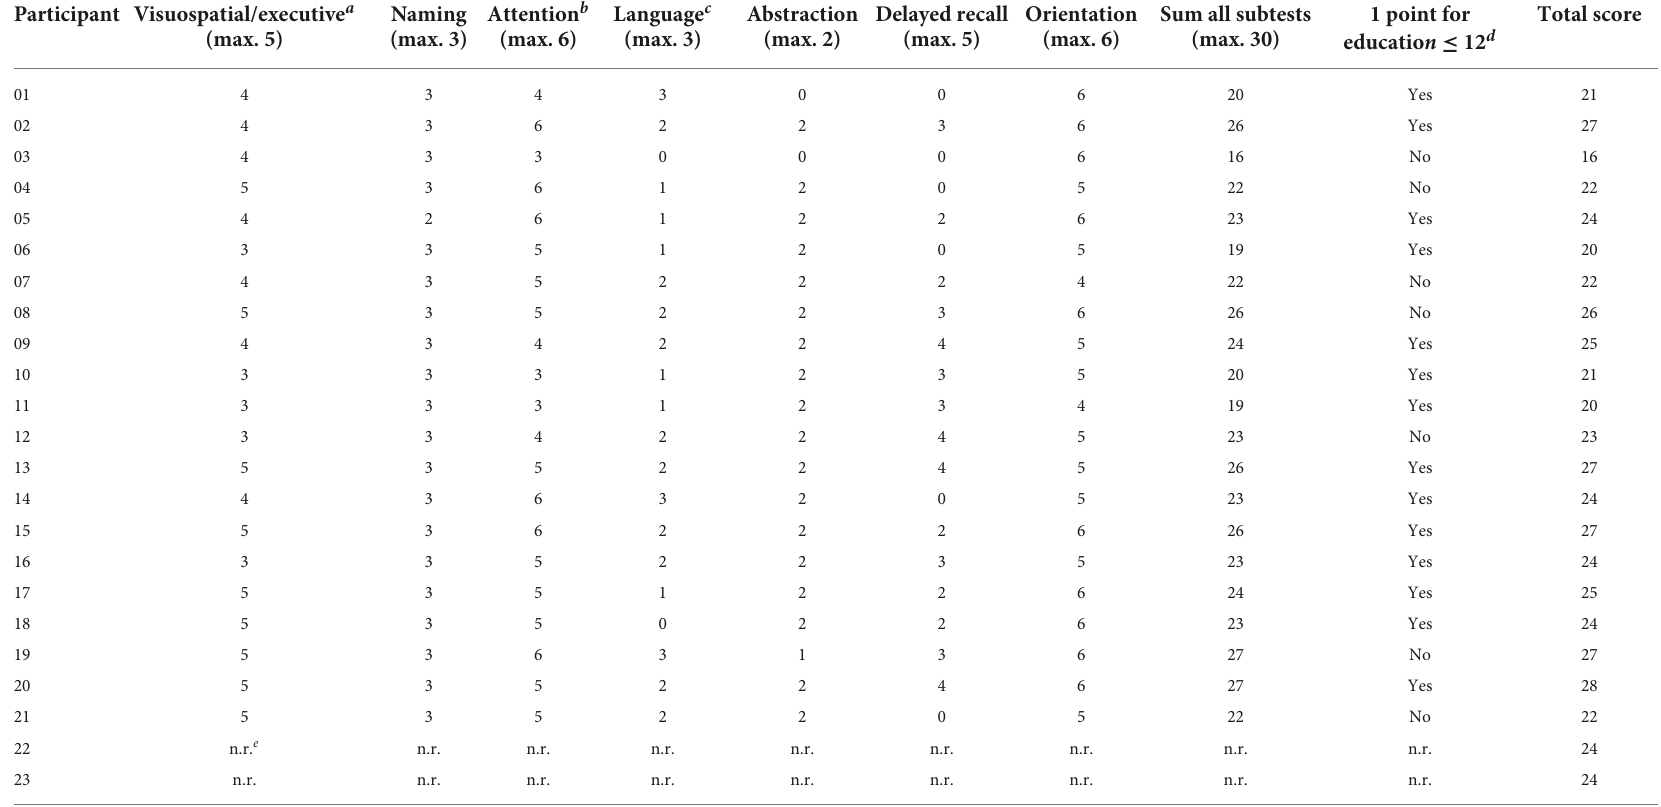
TABLE 3 Scores for the MoCA (subtests and total score) for IwTBI ( n = 23). Participant Visuospatial/executive